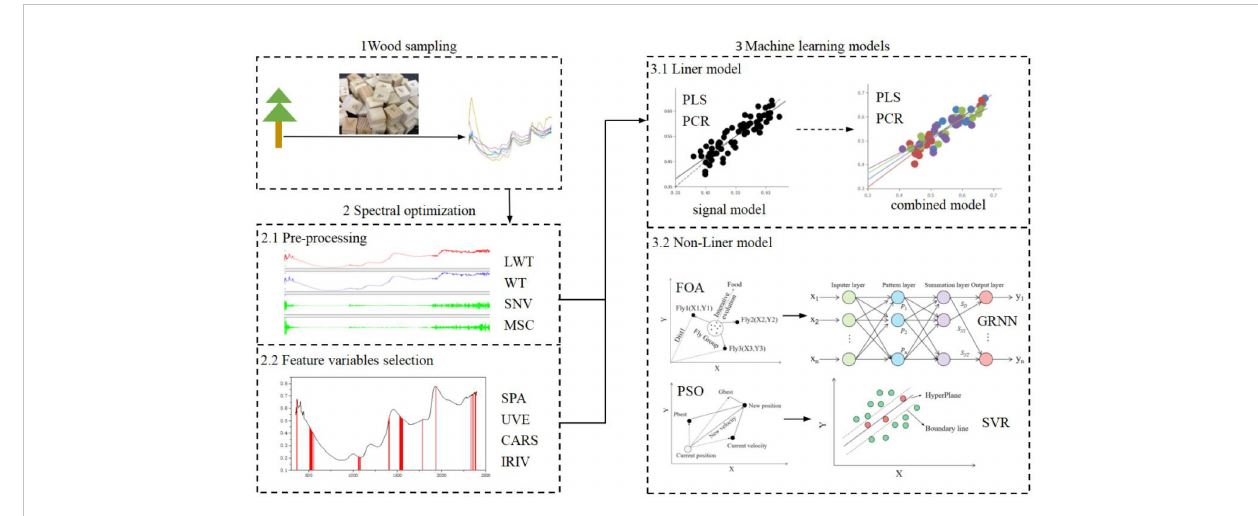
FIGURE 2 The respective work fl ow of chemometric